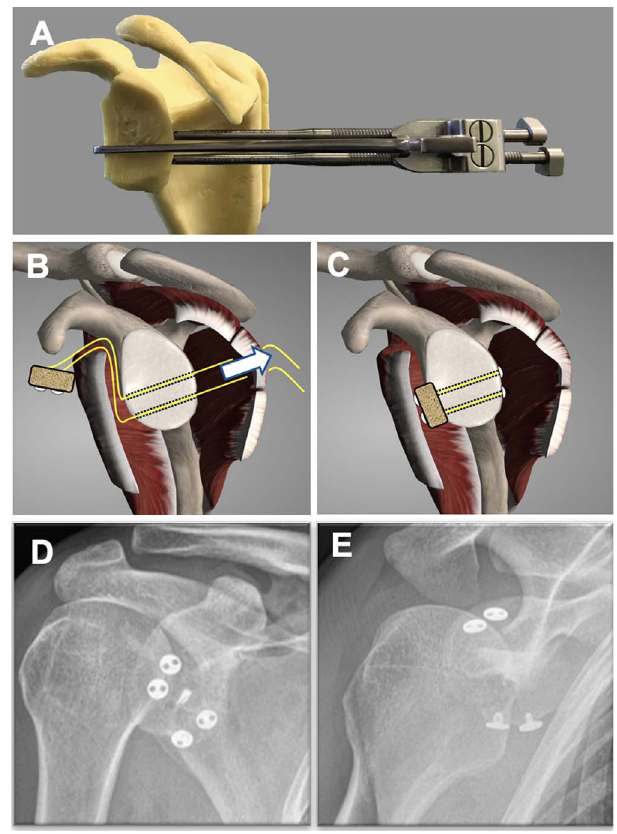
Figure 2. Suture-button